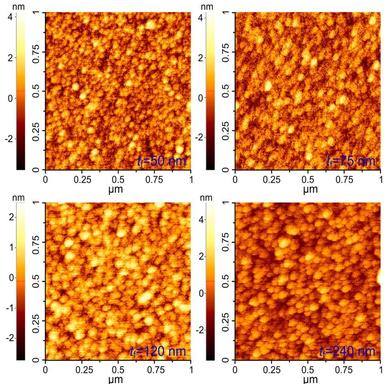
AFM images showing the surface morphology of the Cu film for tf=50 nm, 75 nm, 120 nm, and 240 nm, respectively. No obvious texture was found in these Cu films.